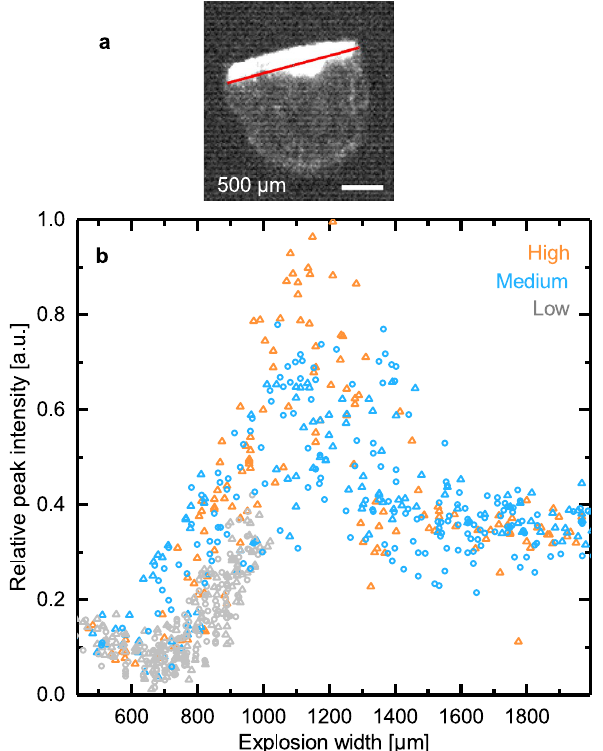
Figure 1. Peak area versus explosion width. ( a ) Explosion width of a droplet. Image taken 5 µs after IR pulse. Image contrast was enhanced for better visualization. ( b ) Peak intensity vs. explosion width for 35_Amer ssDNA. Different explosion widths were achieved by varying laser power and either adjusting droplet position relative to the desorbing IR laser beam within the flight axis (triangle) or adjusting droplet position relative to the laser beam perpendicular to the flight axis (open circle). This figure was prepared in OriginPro 2017 (https :// www.origi nlab.com/). The image in ( a ) was prepared using Fiji 33